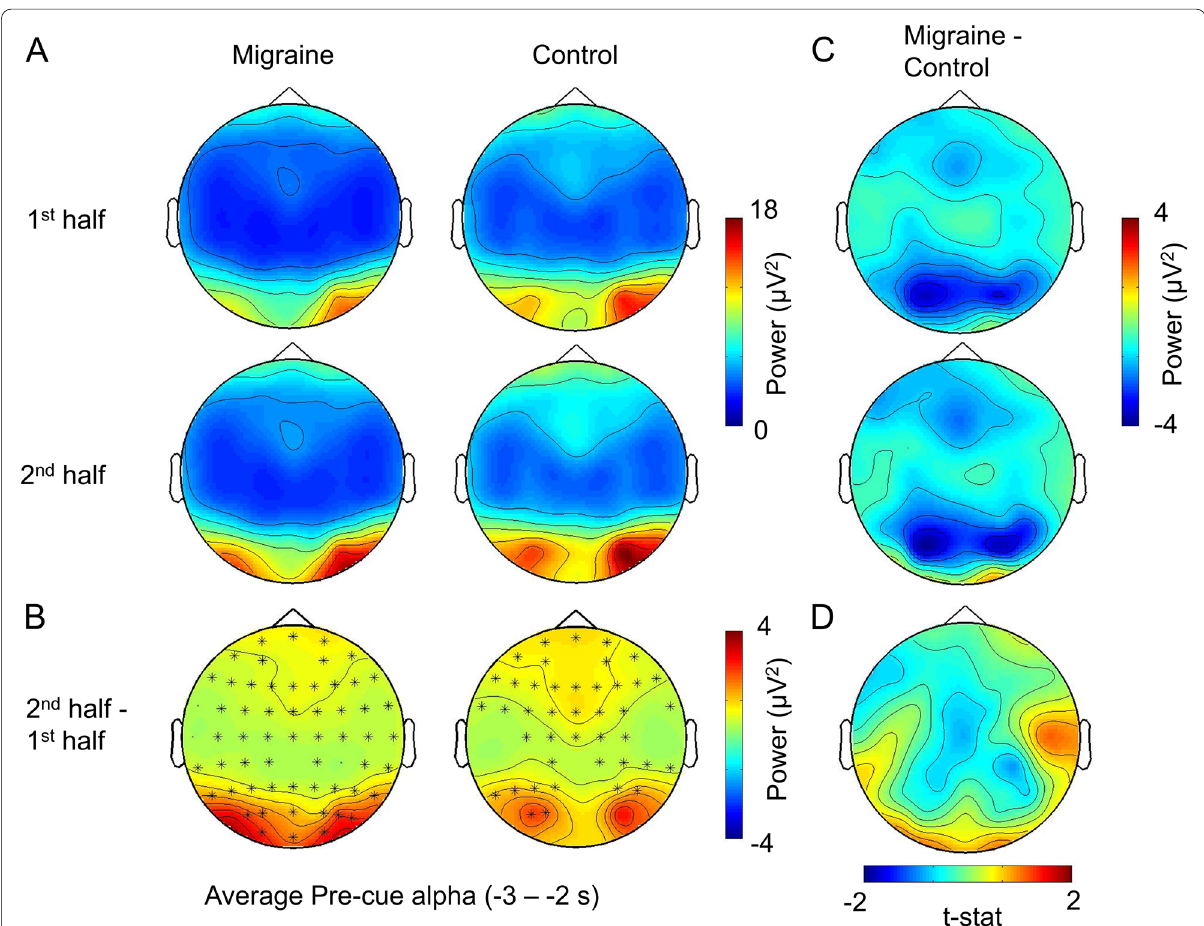
Fig. 5 The average pre-fixation alpha power change between 1st half and 2nd half of the experiment. A The voltage map showed that the pre-cue alpha was the strongest in the occipital area. B Cluster-based permutation analysis on the pre-fixation interval ( stimuli) revealed an enhanced alpha power in 2nd half of the experiment for both migraine and control. The power differences were maximal in the occipital regions (significant channels are highlighted with an asterisk (*) (migraine: p < .001; control: p difference in pre-fixation alpha between migraine and control for both 1st half and 2nd half of the experiment. D The alpha power increase in the 2nd half was also not significantly different between migraine and